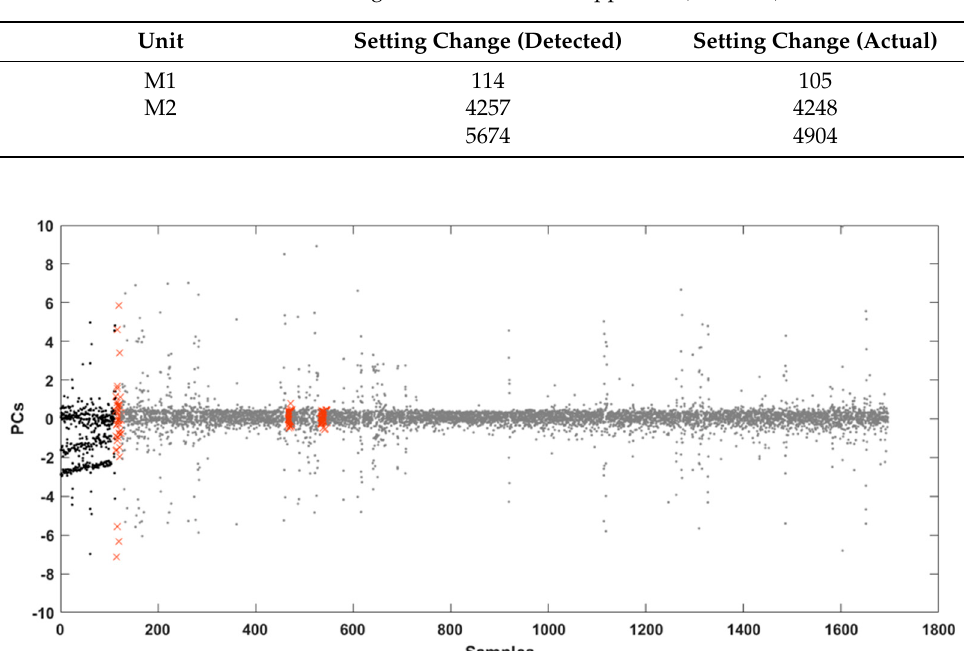
Figure 12. Results of the AAD + ADP algorithm (extruder-M2). Note that, in both cases, there are several data points considered anomalous. How- ever, none of them creates a new cluster. These points correspond to true anomalies in the data, such as measurement errors or anomalous peaks, which are evident in the raw sig- nals. Table 7. Performances of the clustering-based from scratch approach (extruder). Unit